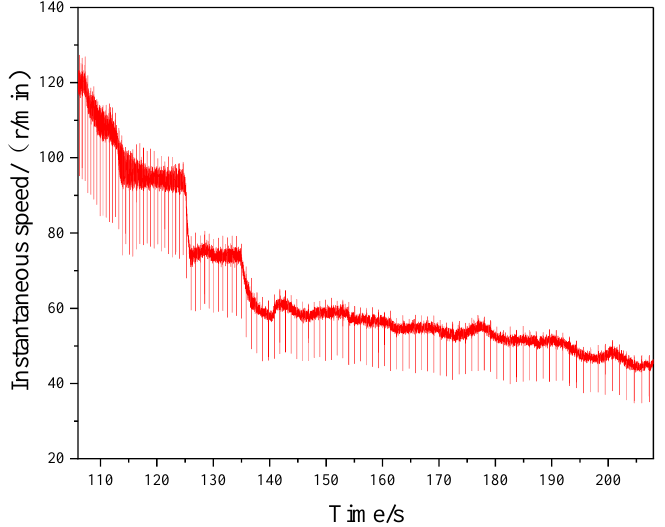
Figure 6. Instantaneous rotational speed of the intermediate shaft during deceleration. A partial amplification of the instantaneous speed of the shafting is performed, as shown in Figure 7. There are obvious burrs in the instantaneous speed signal of the shafting. The main reason for the formation of the burr is the irregular overlap of the coding blet, and the irregular signal is output during signal acquisition. The black and white stripes on the coding belt are of a fixed width. Due to the difference in shaft diameter, the lap joint of the coding belt cannot be perfectly connected after the coding belt is wound once. The black or white stripes will widen or narrow at the lap joint, as shown in Figure 8. The time for the laser sensor to pass the stripe is shorter or longer due to the narrowing or widening of the stripes. The width of the corresponding pulse signal is narrowed or widened, so that the instantaneous rotational speed suddenly increases or decreases.